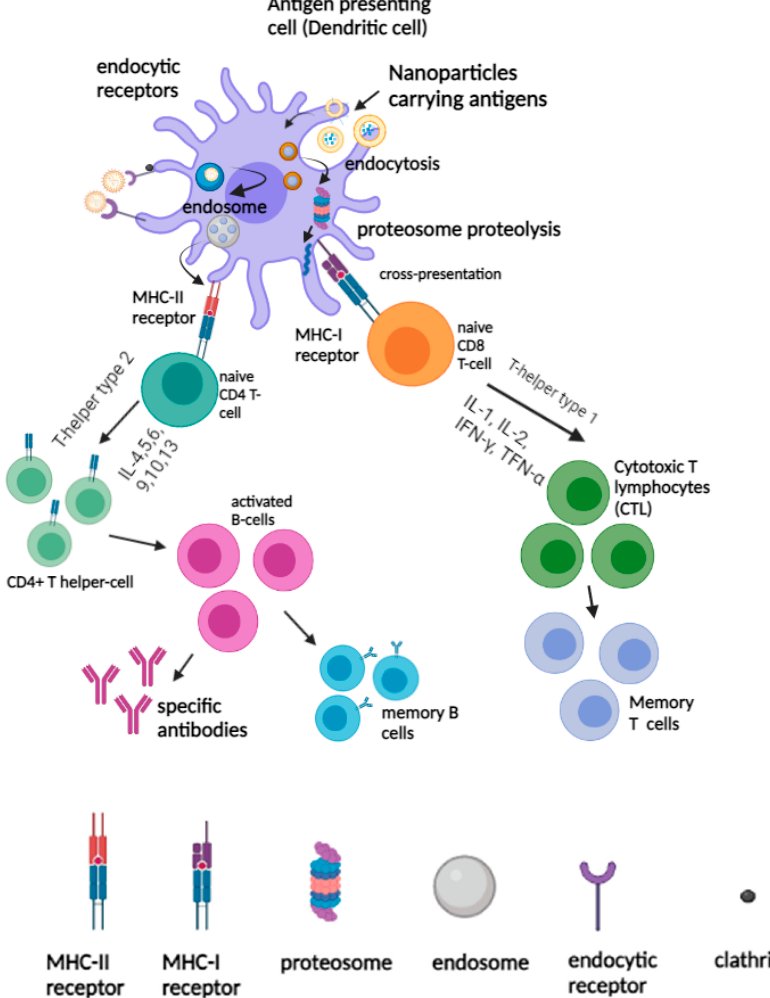
Figure 2. Activation of innate and adaptive immunity by nanovaccines. The uptake and presentation of nanovaccine by APCs (for example, dendritic cells) elicited humoral and cellular immune responses. immune cells. Different shapes (stars, rods, triangles) of methylpolyethylene glycol